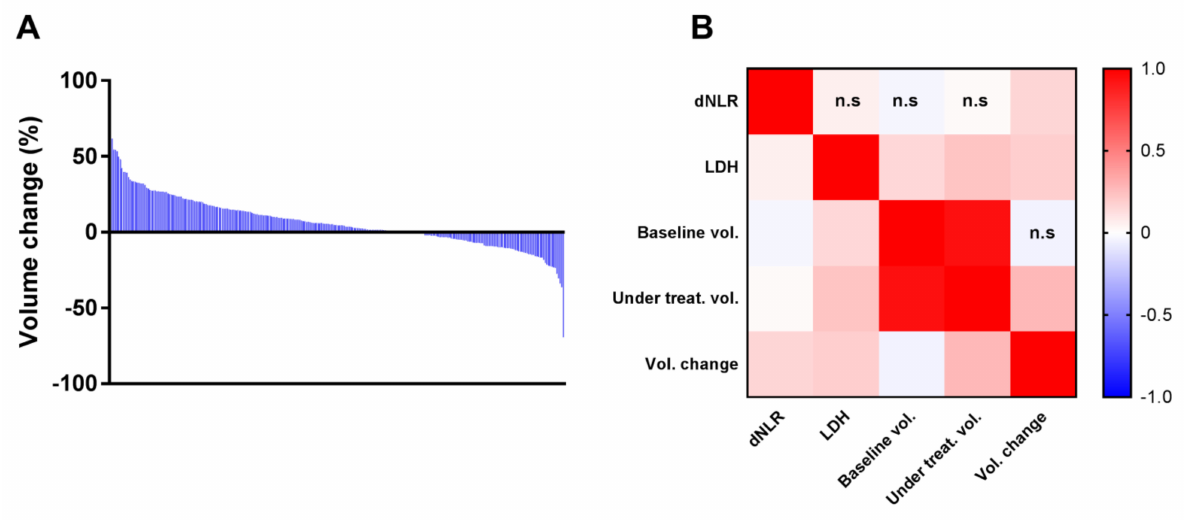
Figure 2. ( A ) Barplot representing decreasing volume changes for all of the patients. ( B ) Heatmap showing Pearson correlation matrix coefficients between splenic volumes, dNLR, and LDH measures n.s: non-significant